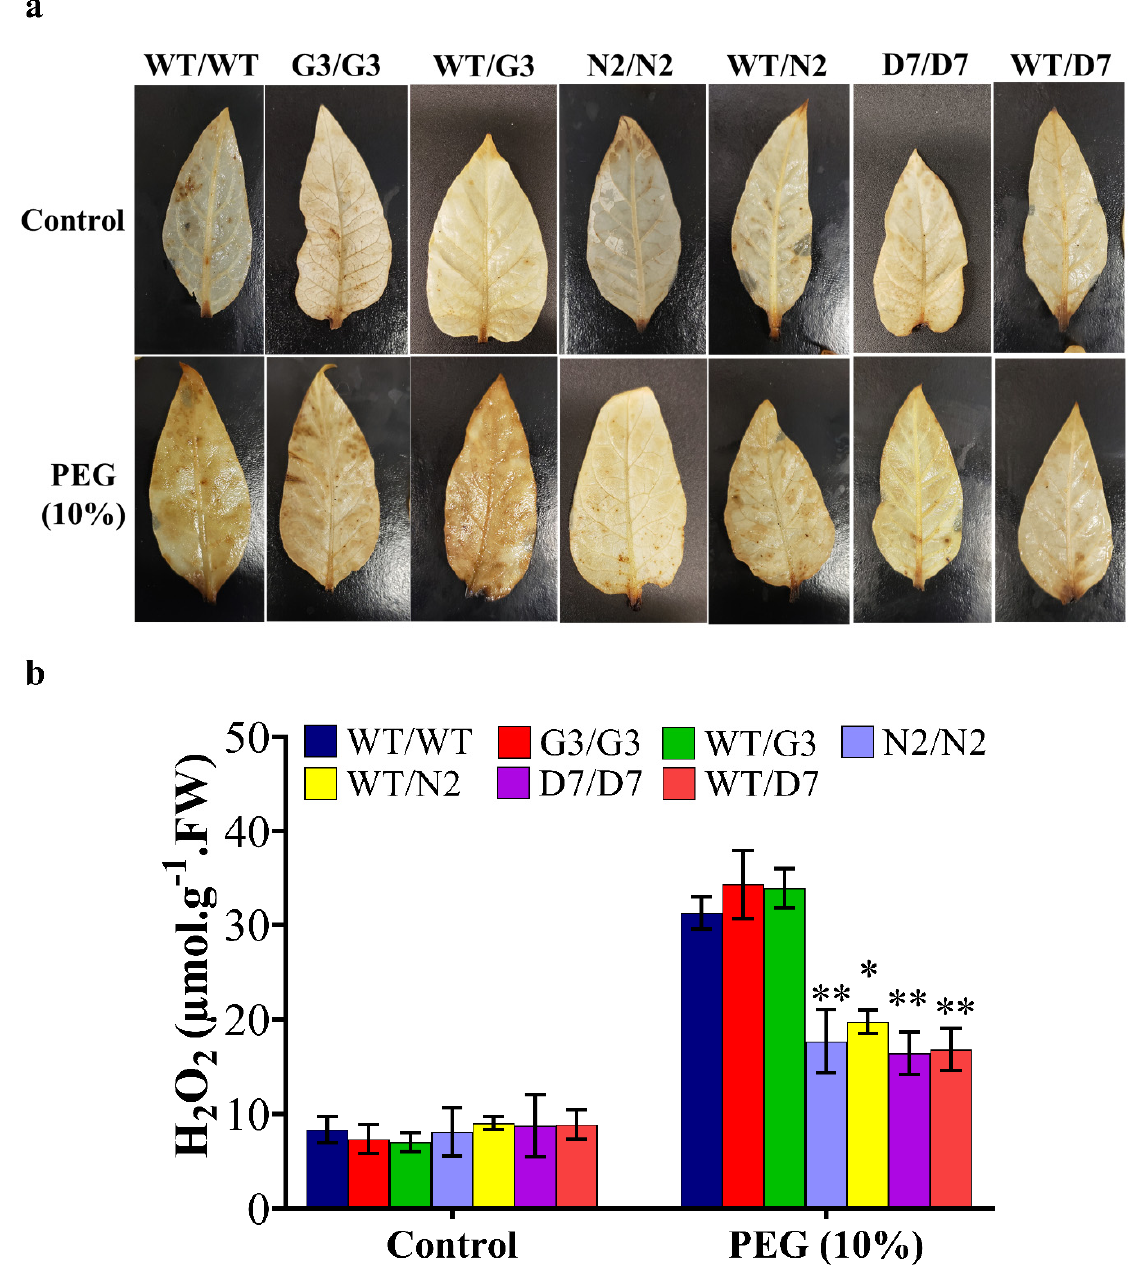
Figure 9. Celluar H 2 O 2 content in the leaves of WT and transgrafted plants under osmotic stress conditions. Histochemical localization ( a ) and quantification of hydrogen peroxide content ( b ) in leaves of transgrafted tobacco plants; WT/WT, G3/G3, WT/G3, N2/N2, WT/N2, D7/D7 and WT/D7 are grafting combinations. The bars represent mean values ± SEM of three biological replicates (four plants each). Asterisk(s) indicate(s) significant differences between the means of wild type (WT/WT) and transgrafts of each treatment group at * p < 0.05, ** p < 0.01 according to Dunnett test.